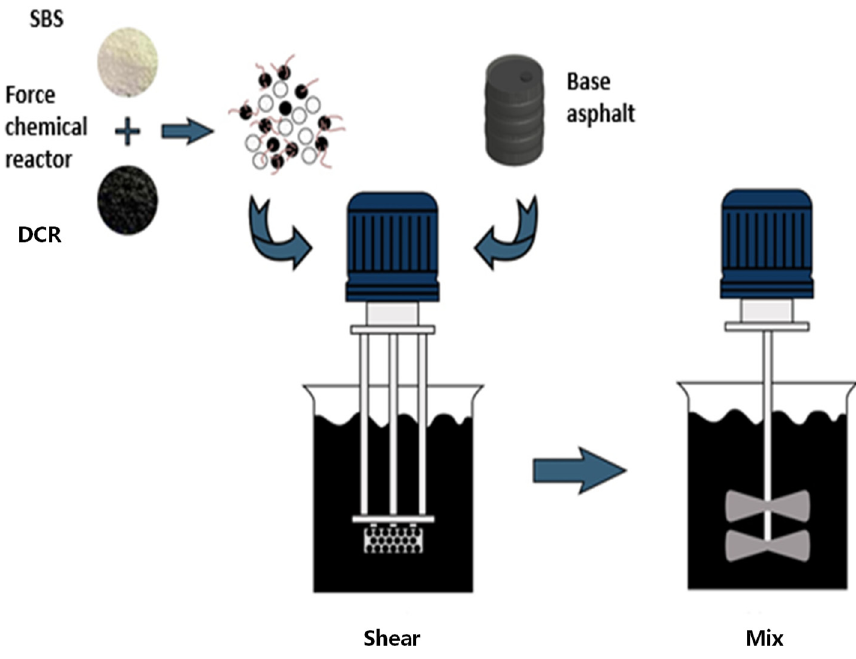
Figure 2. Flowchart of material preparation.